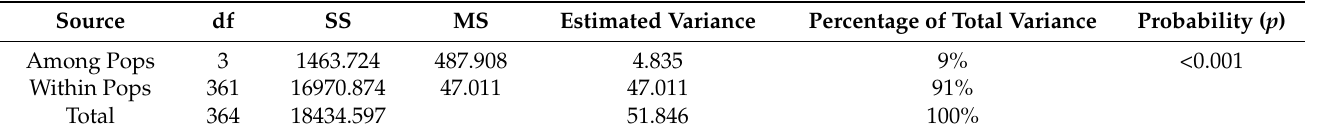
Table 5. The AMOVA analysis for the geographical populations in the collection of 365 landraces.